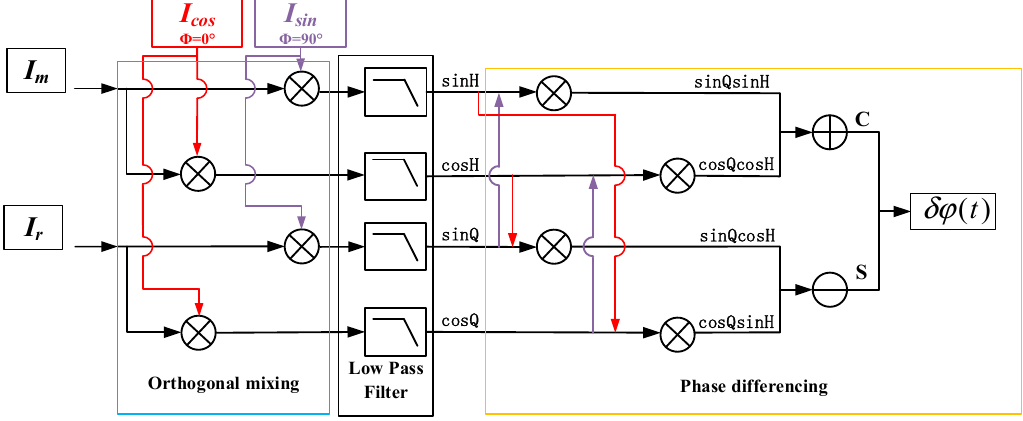
Figure 2. Schematic of the measurement method for nonlinearity in heterodyne laser interferometers based on a double-channel quadrature demodulation.